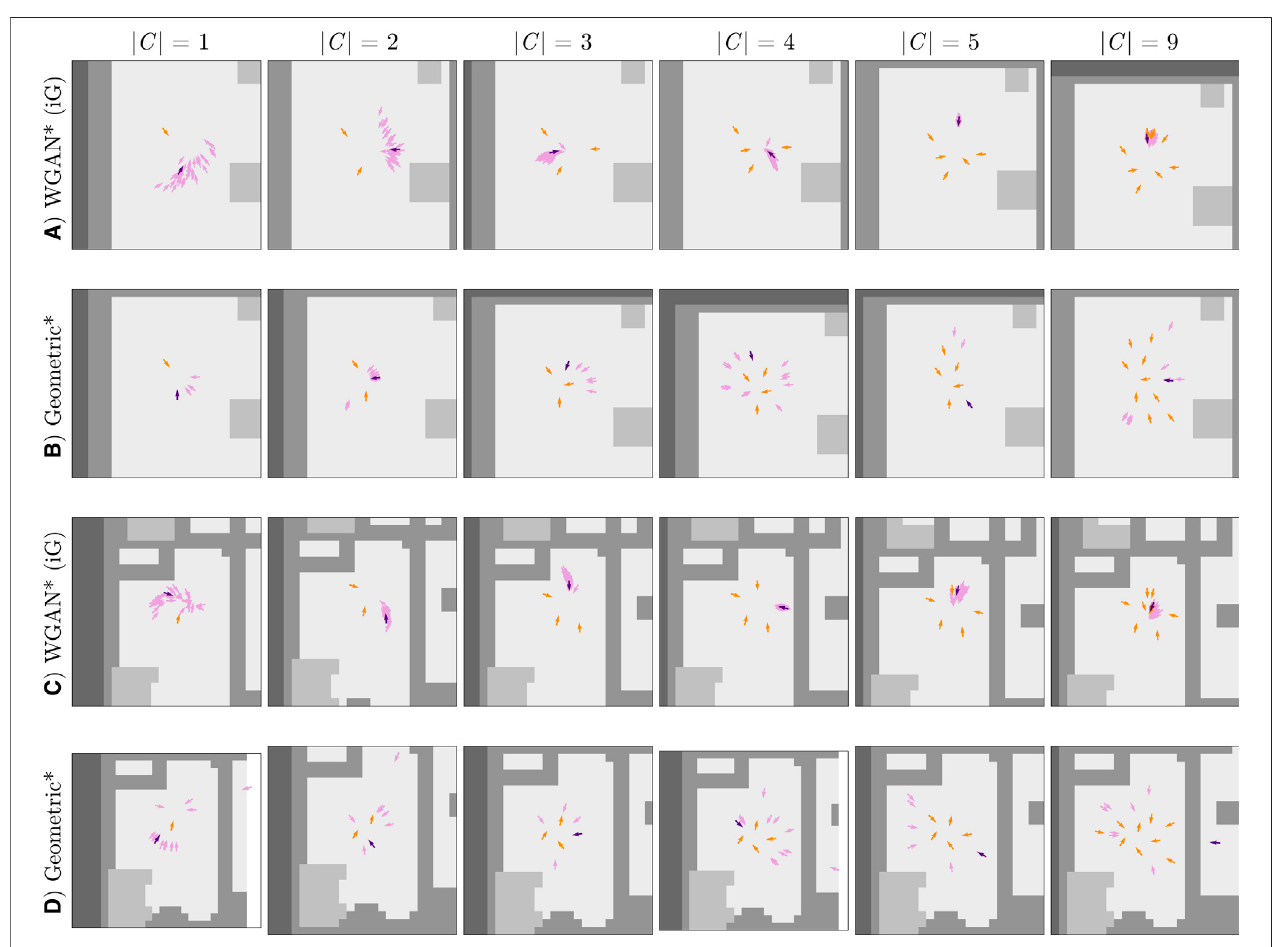
FIGURE 10 | Group generation through iterative invocations of the geometric and data-driven approaches. The plots in rows (A) and (B) show results in the map fromtheCocktailPartydataset.Rows (C) and (D) demonstrateourtwoapproachesinamapfromtheiGibsondataset.Asin Figure6 ,theorangearrowscorrespondto theposesinthecontext C ,thepurplearrowsareGroundTruthorpredictedposes,andthelightergraycolorinthemapscorrespondstofreespace.| C |indicatesthesize of the context used to make a prediction per column. This Figure is best viewed in color.